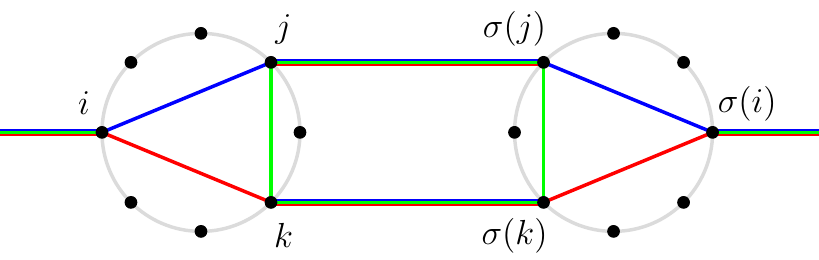
Figure 9. To get a melonic diagram, the external legs must be connected to vertices in the two interactions that are related by an